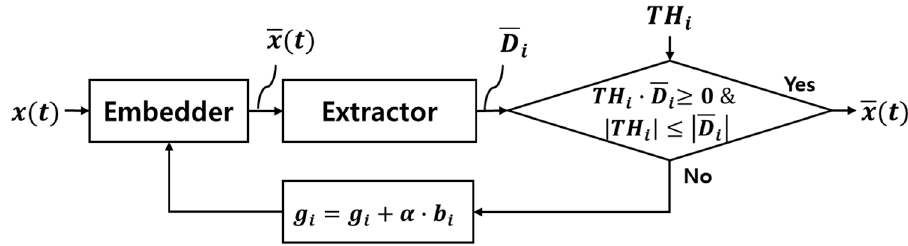
Figure 7. Feedback Figure 7. Feedback process. Figure 7. Feedback process.